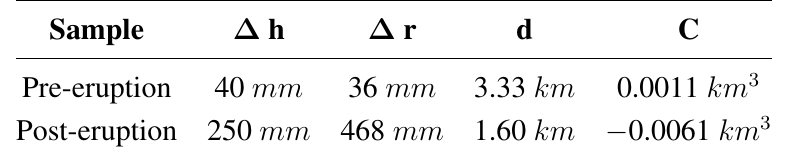
Table 4. Estimated Mogi source parameters derived from GFUM 240 days before and 30 days after the 2011 Grimsv¨otn Eruption, where positive or negative values of C indicate uplift or subsidence.